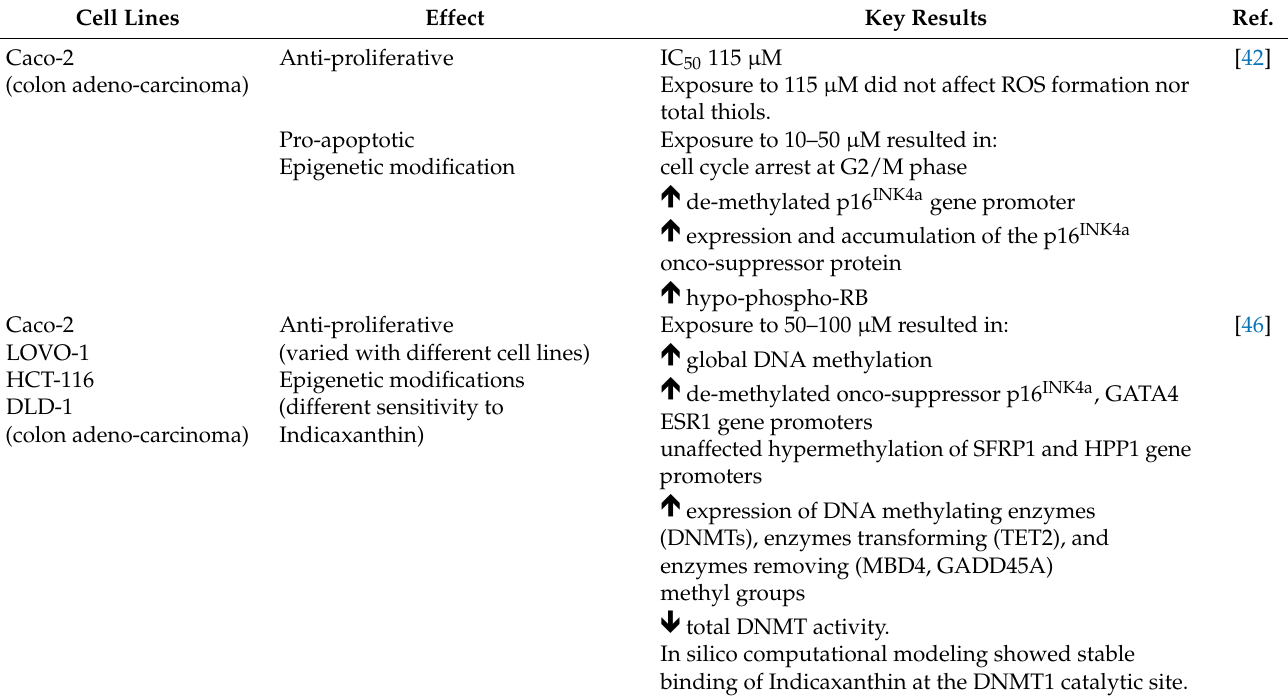
Table 4 summarizes the effects of Indicaxanthin in tumor cells. Table 4. Activity of Indicaxanthin in human tumor cells. Table 5. Activity of Indicaxanthin in C. elegans. Table 6. Activity of Indicaxanthin in murine